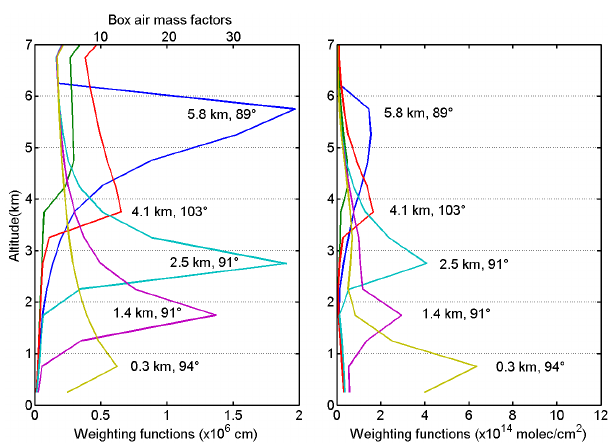
Fig. 4. Some of the weighting functions relative to the NO 2 slant column measurements of the 8 April 2008 in linear (left panel) and loga- rithmic (right panel) scale. Beside the altitudes of observations are indicated the telescope line-of-sight angles (0 ◦ is nadir, 90 ◦ horizontal).